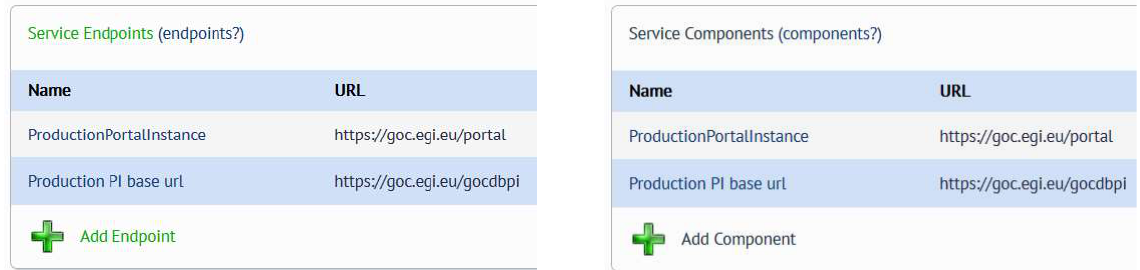
Fig. 3. The traditional terminology (“Service Endpoints”, left) and the EOSC-hub terminology (“Service Components”, right)